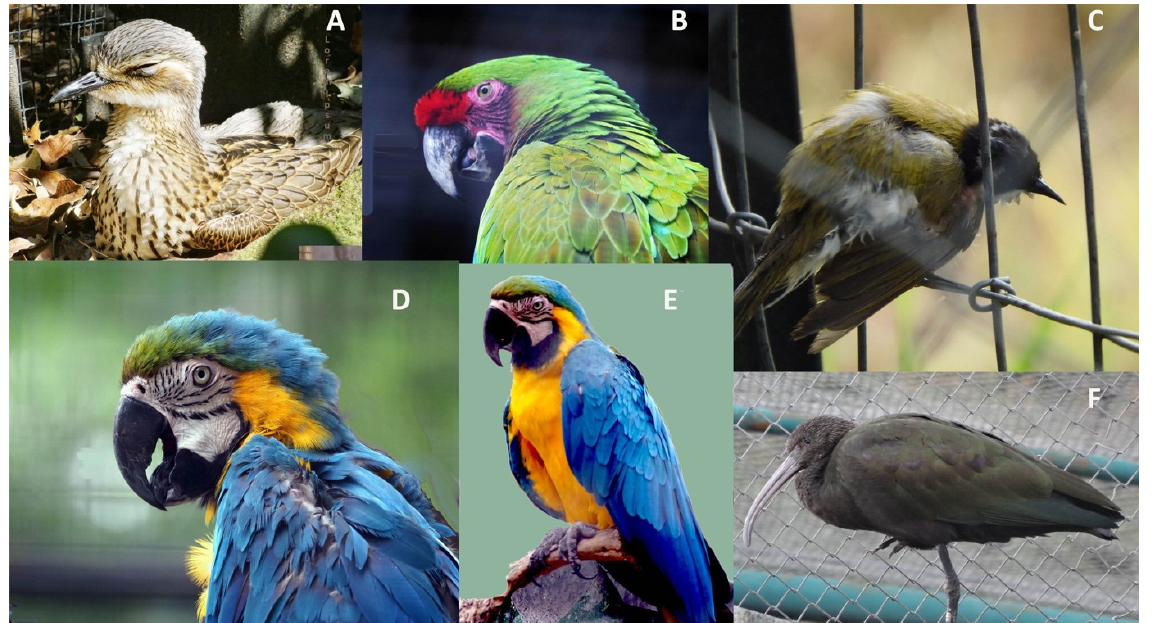
Figure 2. Overt signs of discomfort or distress. From left to right, top row: ( A ) Australian bush stone-curlew, Burhinus grallarius , a very shy bird, shutting its eyes when watched by humans and not being able to get away. The eye closing, in the case of largely nocturnal birds, may simply be a sign of brief sleeping bouts. In other cases, it can be a sign of stress, pain, or both. Closed or semi-closed eyes in diurnal birds can indicate acute cases of illness or stress. ( B ) Military macaw, Ara militaris , turning away and raising feathers on the nape of the neck is a passive–aggressive posture. ( C ) Small songbird in active-aggressive mode in fear and about to flee: drooping flight-feathers, arching back, and raising feathers on the back. Bottom row: ( D , E ) Blue and yellow macaw, Ara ararauna . Two different postures indicating deep distress, first image: wings raised and slightly fluffed and head slightly forward; second image: wings hanging and head slightly to one side and lowered. ( F ) Glossy ibis, Plegadis falcinellus , long neck retracted and head slightly to the side, standing on one leg. The raised leg may well indicate a brief resting respite for the foot, without problems, but in some cases may suggest problems with a foot (injury or swelling) and as shown here, it is likely that this bird is in pain (after watching it for several hours, it never changed legs and kept just the left leg tucked away). Another variant is to adopt a sleeping position with the head buried amidst flight feathers. However, this posture, often with eyes shut completely, hints at more than psychological distress and rather suggests some form of illness (Photo credit: G. Kaplan).